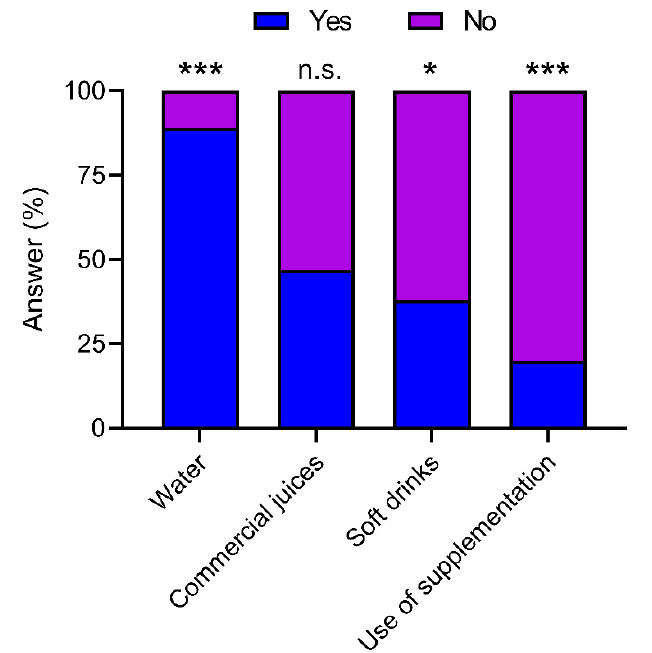
Figure 3. Main beverage in meals and use of supplements for the total sample. *, p ≤ 0.05; ***, p ≤ 0.001; n.s., not significant.